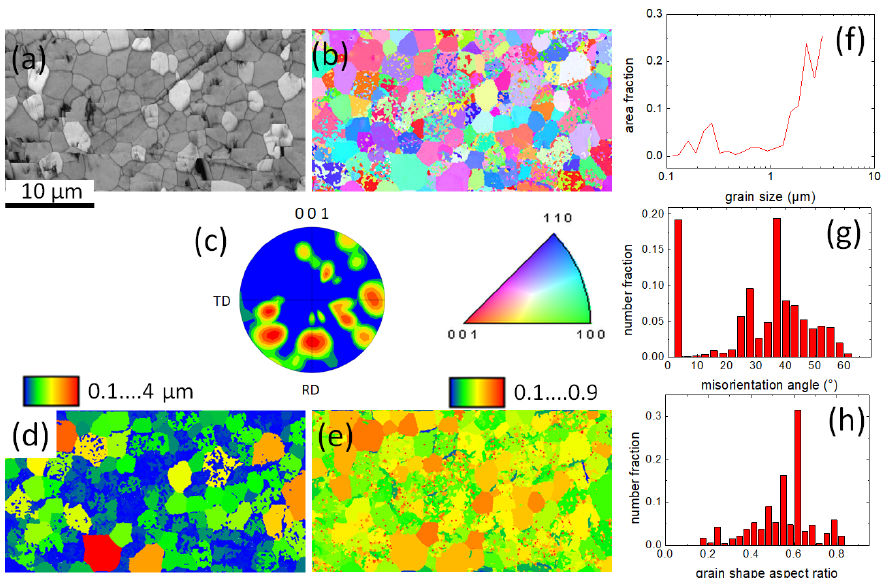
Figure 7. EBSD analysis of the 122 reacted-and-pressed powder sample. (a) is an image quality (IQ) Figure 7. Electron backscatter diffraction (EBSD) analysis of the 122 reacted-and-pressed powder map, (b) gives the orientation mapping in direction normal to the sample surface. The color code for sample. ( a ) is an image quality (IQ) map; ( b ) gives the orientation mapping in the direction normal to this map is given in the stereographic triangle below the map. (c) presents the corresponding pole figure in [001]-direction (i.e., normal to the sample surface, or ND), (d) is a grain size mapping, and the sample surface. The color code for this map is given in the stereographic triangle below the map; (e) is a map of the grain size aspect ratio. The color codes for the maps (d) and (e) are indicated on ( c ) presents the corresponding pole figure in the [001]-direction (i.e., normal to the sample surface, or top of each map. The plots (f), (g), and (h) illustrate details of the sample microstructure. (f) gives the ND); ( d ) is a grain size mapping, and ( e ) is a map of the grain size aspect ratio. The color codes for statistics of the EBSD-determined grain size, (g) the distribution of the misorientation angles, and (h) the maps ( d , e ) are indicated at the top of each map. The plots ( f – h ) illustrate details of the sample the statistics of the grain shape aspect ratio. For details, see the main text. microstructure. ( f ) gives the statistics of the EBSD-determined grain size, ( g ) the distribution of the misorientation angles, and ( h ) the statistics of the grain shape aspect ratio. For details, see the main